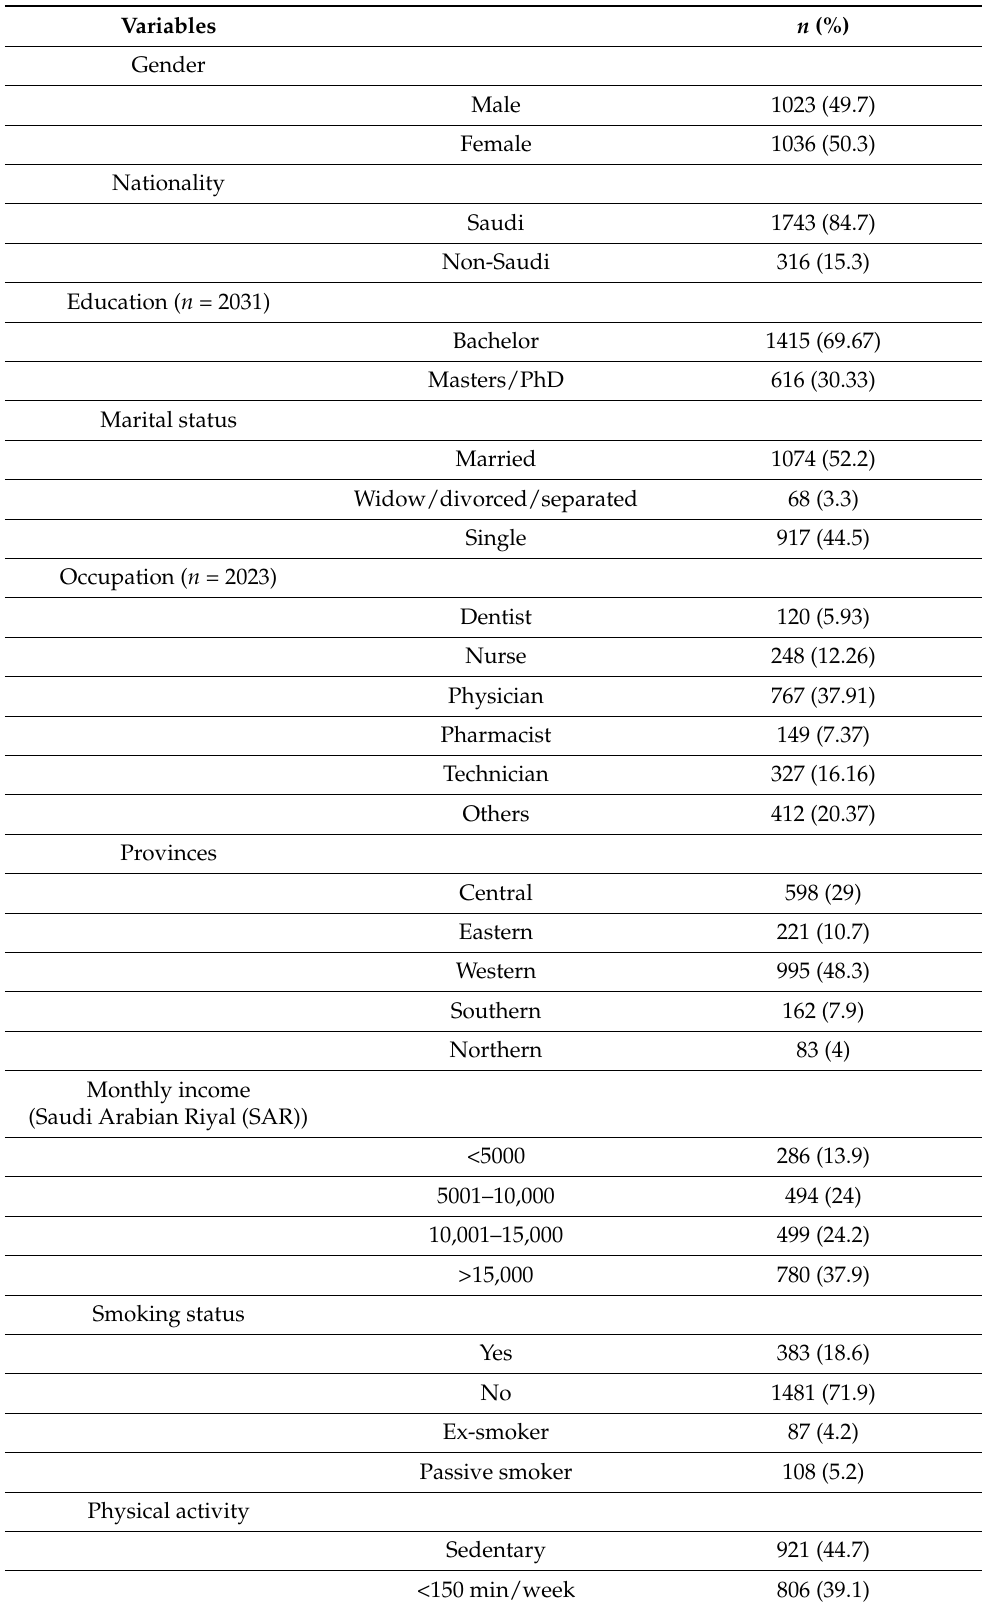
Table 1. Socio-demographic